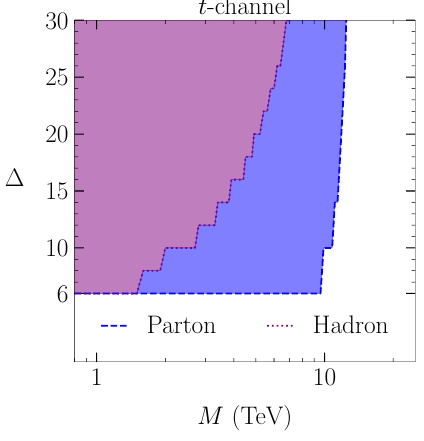
Figure 7 . The shaded region shows the parameter space where the EFT is invalid for the t -channel model in the plane of the EFT truncation dimension ∆ versus the BSM scale M with λ qφ = 8 π . In the Partonic (Hadronic) Initial State case, we take effects opens up a region of potentially viable parameter